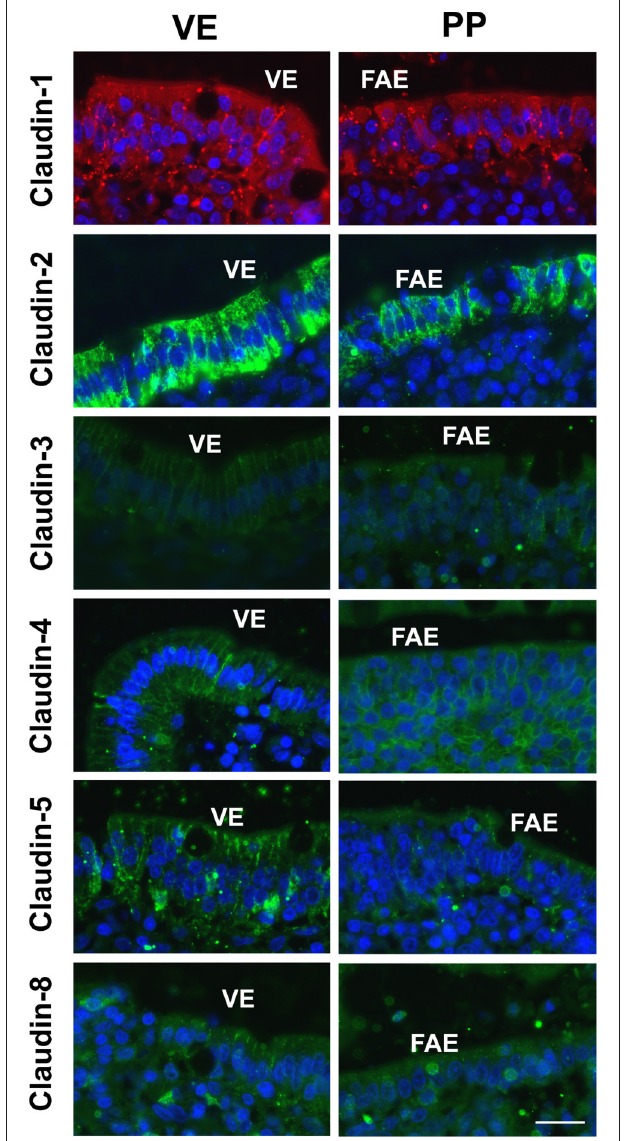
FIGURE 4 | Immunofluorescent staining revealed signals of all claudins within epithelial cells in Peyer’s patch follicle-associated epithelium (PP FAE) and neighboring villous epithelium (VE). The majority of claudins was detected in the apicolateral membrane, including claudin-4 in PP FAE ( n = 5, respectively, bar: 20 µ m).